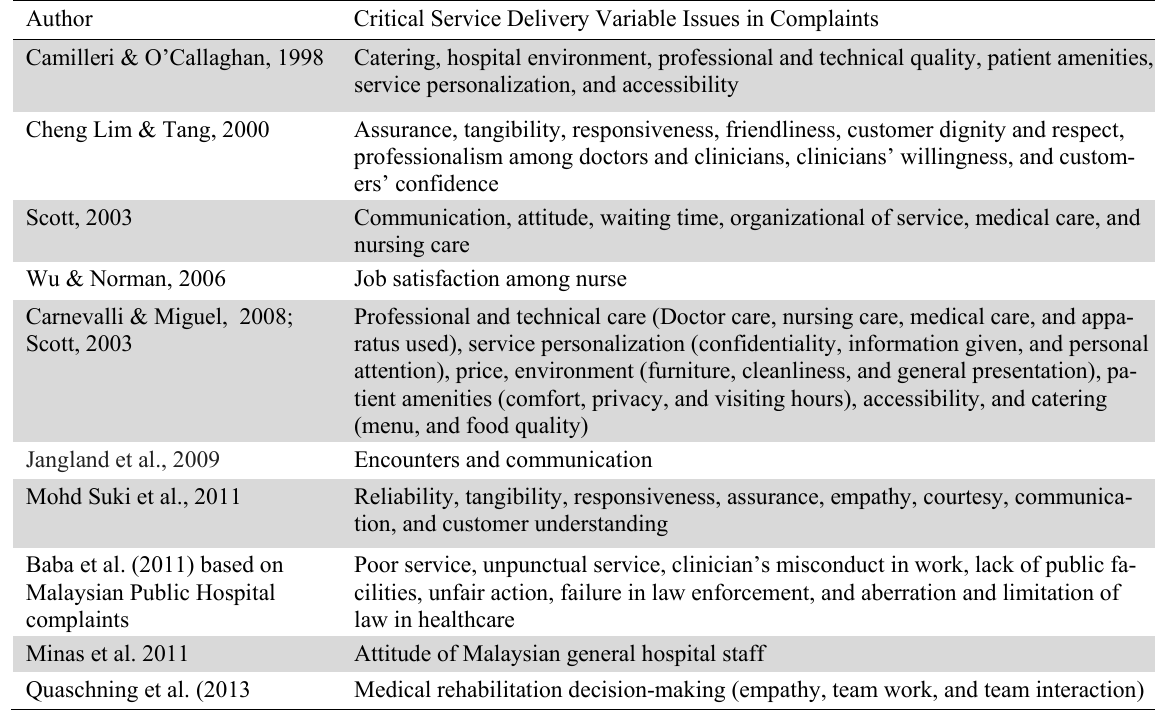
Summary of service delivery variables in